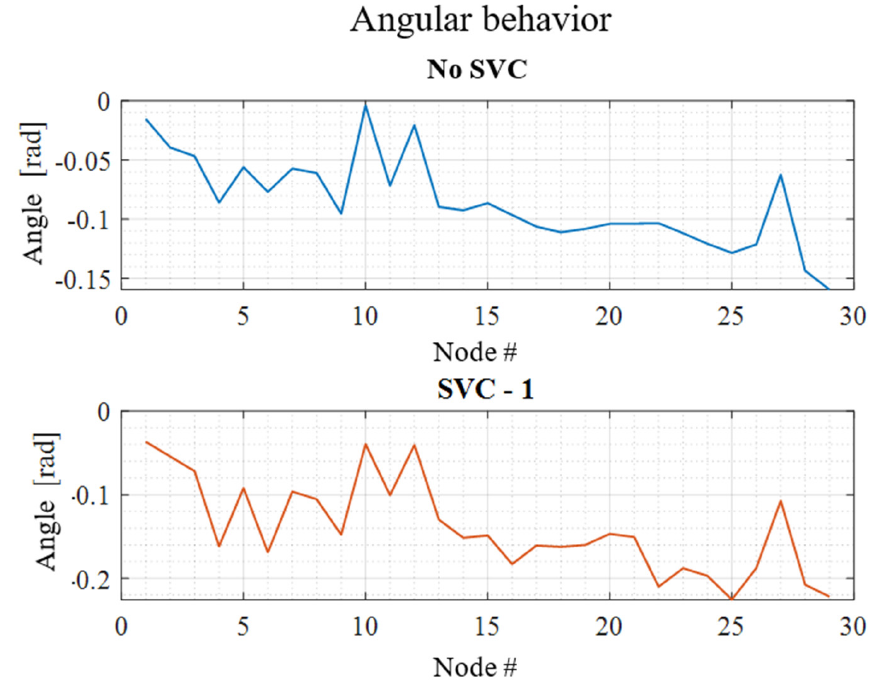
Figure 16. Angle profile in the IEEE 30-bus test system.